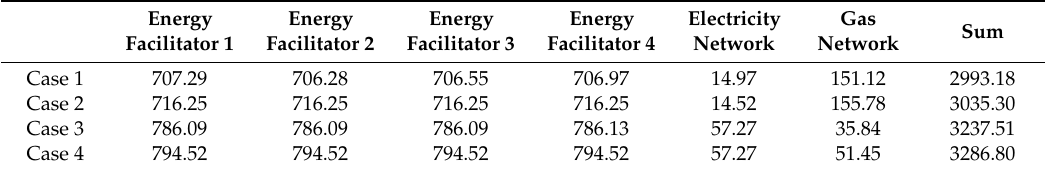
Table 4. Energy cost for 24 h